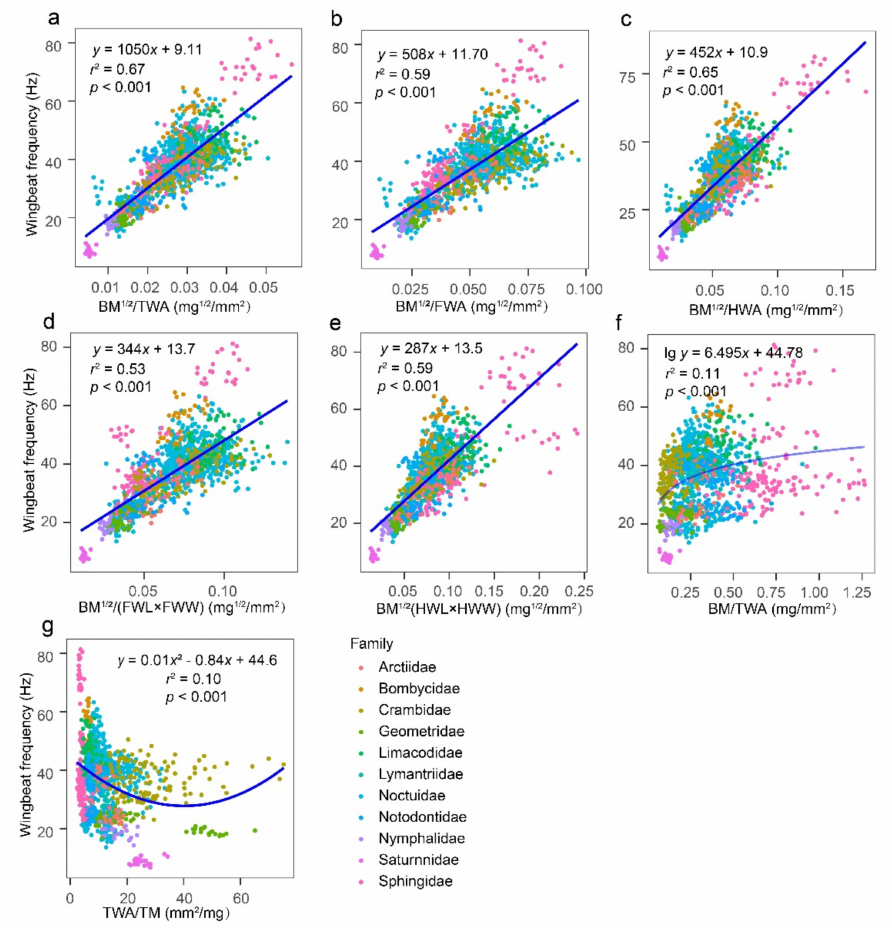
Figure 6. Regression models for wingbeat frequency and morphological variables ( a ) the square root of body mass divided total wing area, ( b ) the square root of body mass divided forewing area, ( c ) the square root of body mass divided hindwing area, ( d ) the square root of body mass divided by the product of forewing length and forewing width, ( e ) the square root of body mass divided the product of hindwing length and hindwing width, ( f ) body mass divided total wing area, and ( g ) total wing area divided by thoracic mass, for all tested lepidopterans. BM, body mass; BM 1/2 , the square root of body mass; TM, thoracic mass; AM, abdominal mass; BL, body length; BW, body width; FWL, forewing length; FWW, forewing width; HWL, hindwing length; HWW, hindwing width; FWA, forewing area; HWA, hindwing area; and TWA, total wing area. A total of 1344 individuals were used in this